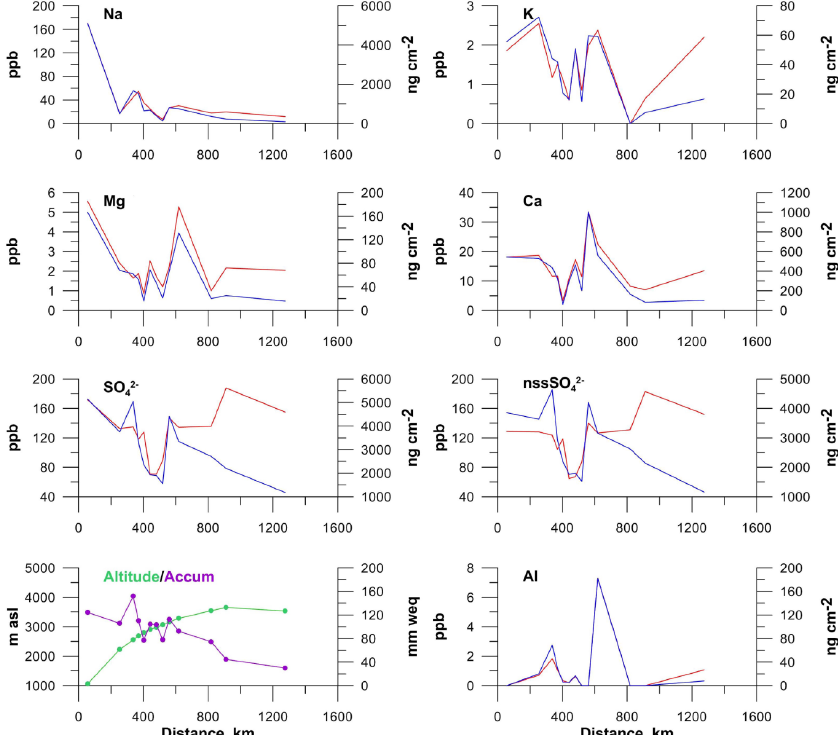
Fig. 4. Averaged (approximately for the 2006–2008 time interval) snow major ion concentrations (red) and fluxes (blue) versus distance for the Progress–Vostok transect. Distance is measured from the Progress station in km. Mean accumulation rates (purple) and elevation (green) are shown on separate diagram (lower left corner).